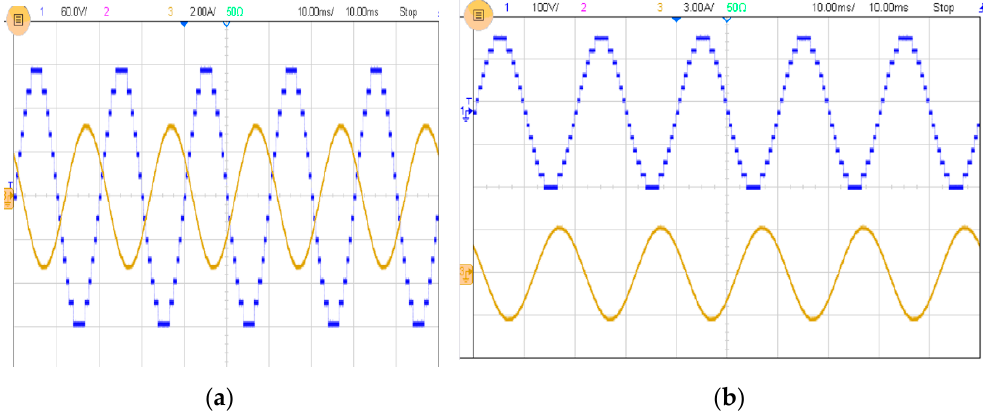
Figure 12. The experimental value of output voltage and current waveform in the 13-level inverter ( a ) with balancing load and ( b ) with load changes.